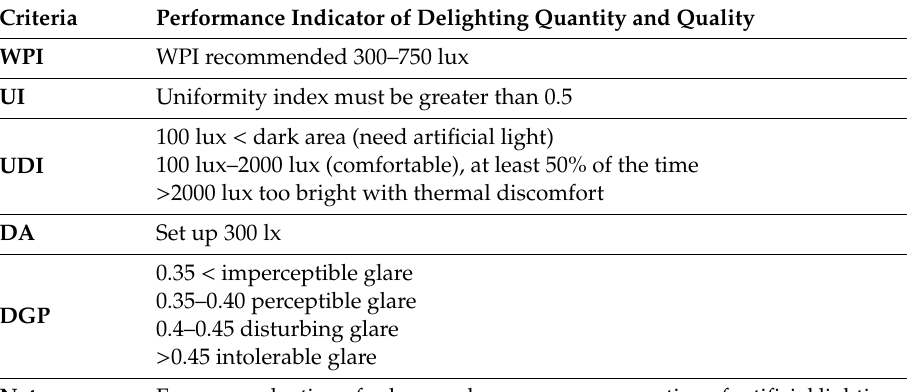
Figure 5b. The illumination sensors were placed 0.85 m above the floor surface, based on the height of the work plane. Their operating profiles follow their real use from 8.00 a.m. to 5.00 p.m. Table 6. The performance indicators of visual comfort used in this